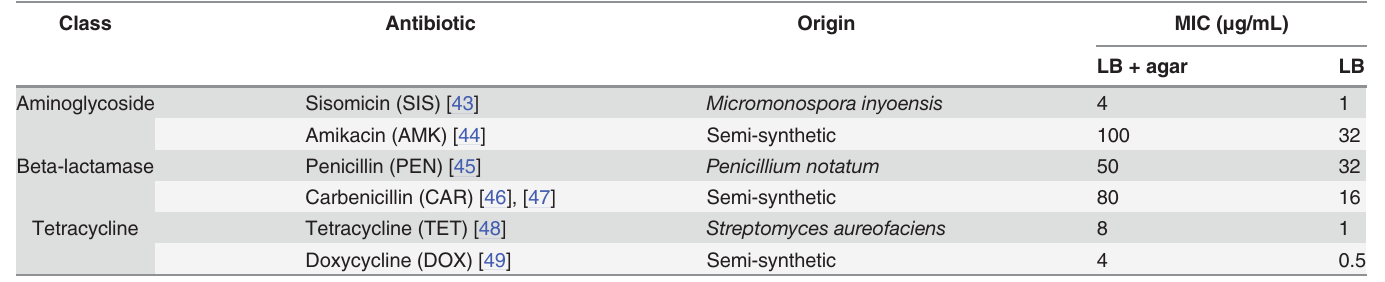
Table 1. List of antibiotics and minimal inhibitory concentration (MIC) used in this study.